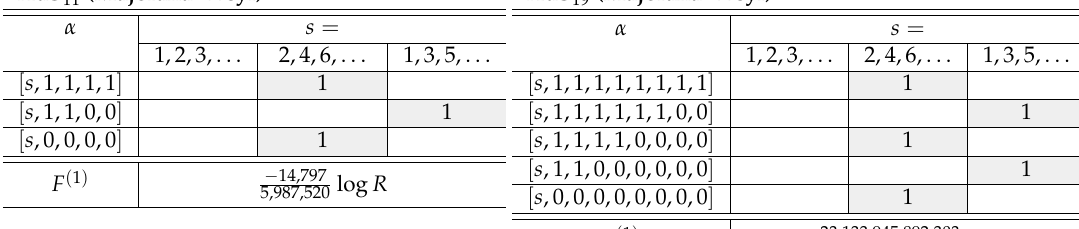
Table 4. Table of weights and their towers of spins for (top left) AdS 11 and (top right) AdS 19 under Majorana–Weyl projection, and for (bottom left) AdS 7 and (bottom right) AdS 15 under the Symplectic Majorana–Weyl projection. There are no subscripts c for the [ s ,1, . . . ,1 ] representations because the dual representations [ s ,1, . . . ,1, − 1 ] are not